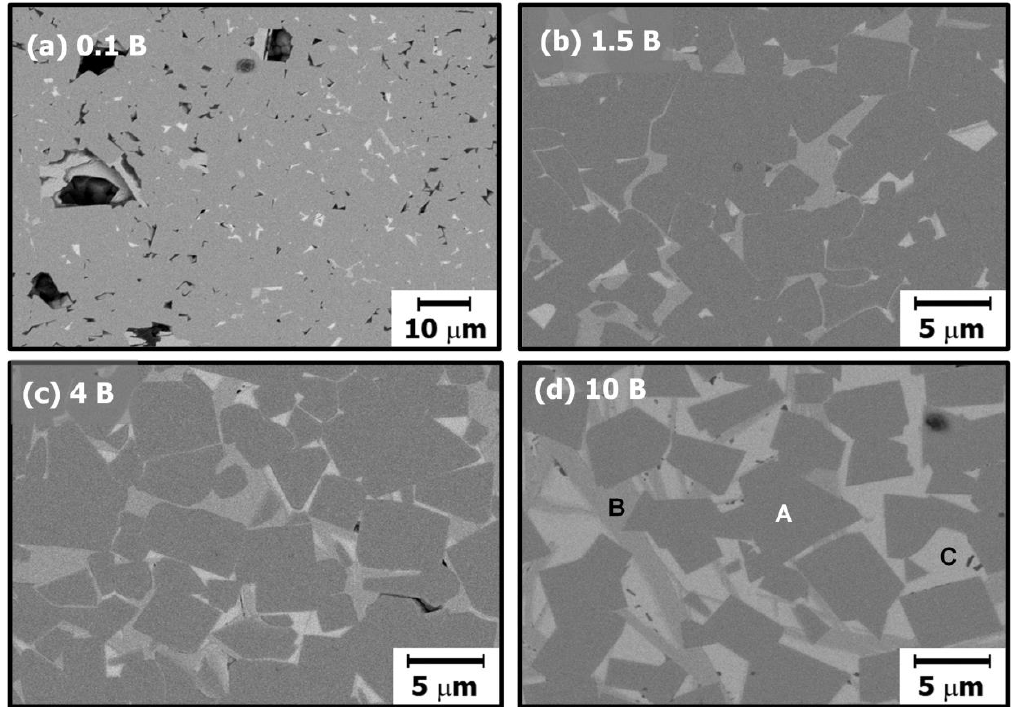
Figure 4. Backscattered SEM images (BSE mode) without chemical etching treatment of ( a ) 0.1 mol%, ( b ) 1.5 mol%, ( c ) 4 mol%, and ( d ) 10 mol% Bi 2 O 3 -excess 0.95Na 0.5 Bi 0.5 TiO 3 -0.05BaTiO 3 (NBT–5BT) samples sintered at 1200 °C for 48 h. Table 1. Energy dispersive spectroscopy (EDS) analysis results with 10 mol% Bi 2 O 3 -excess